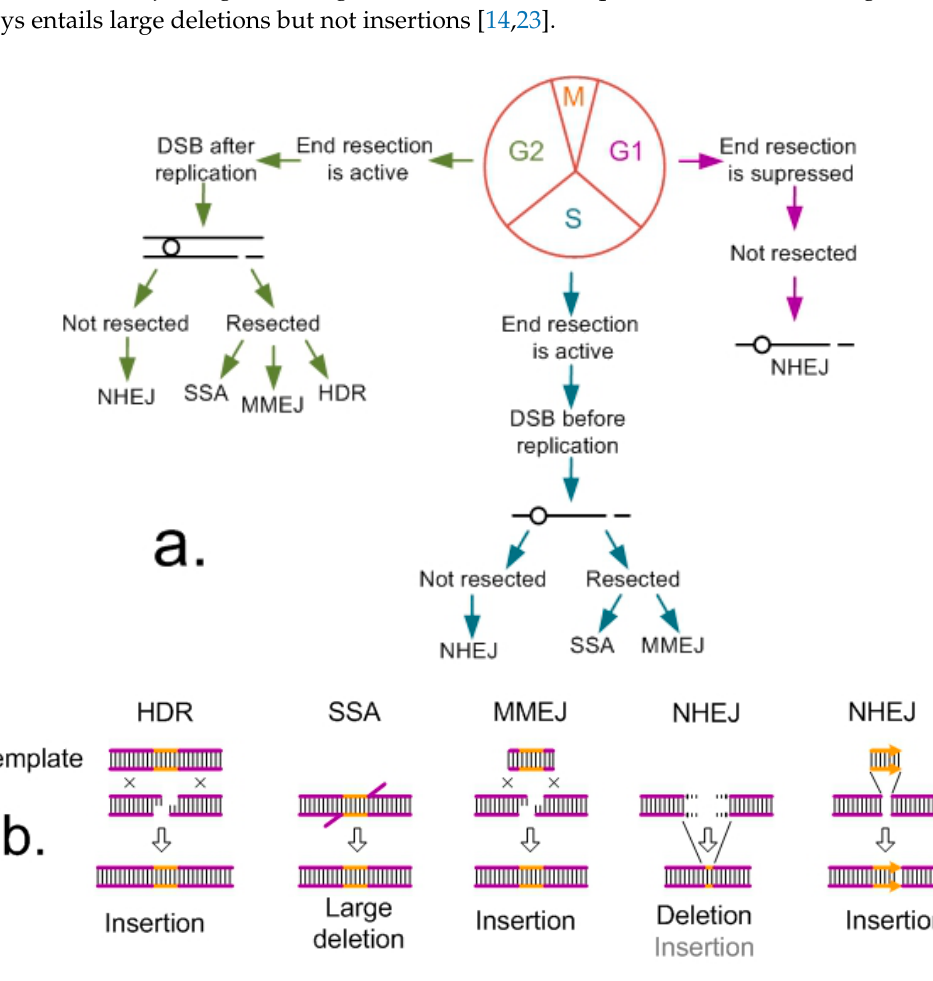
Figure 1. Main mechanisms of double-strand break (DSB) repair in eukaryotes: ( a ) Dependence of the choice of repair pathway on the phase of the cell cycle and ( b ) the results of repair by different mechanisms in the presence and absence of a donor template.